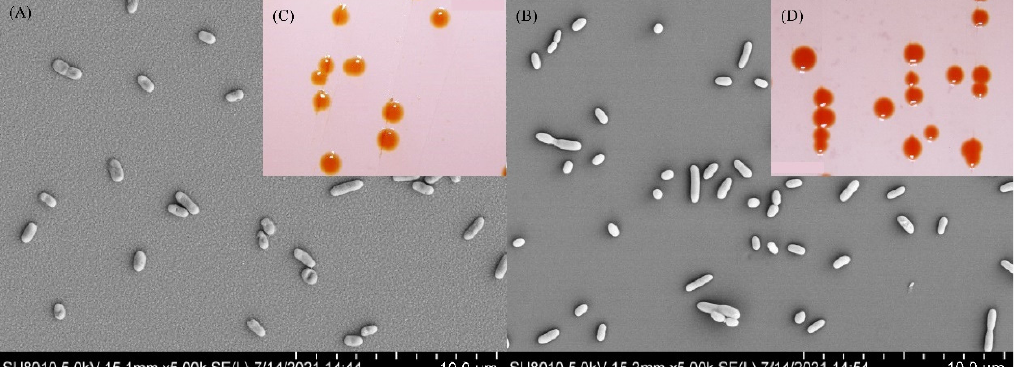
Figure 3. Scanning electron microscope photos showing the morphological structure of the cells of strain S5-59 T ( A ), S8-45 T ( C ), and plate colonies’ morphology of S5-59 T ( B ), and S8-45 T ( D ).